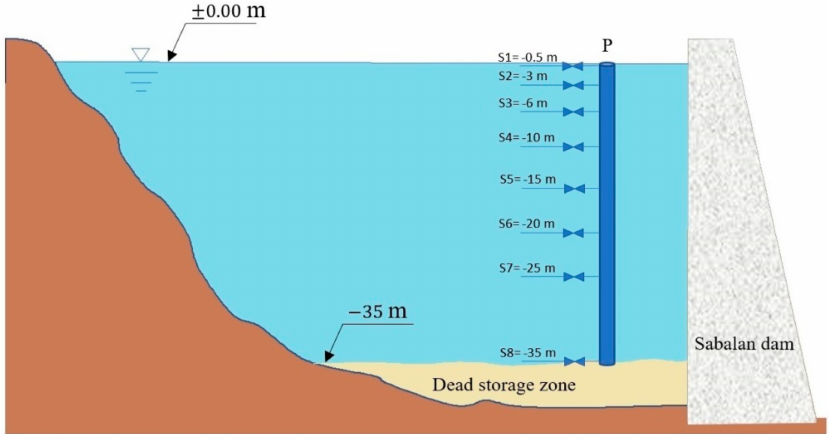
Figure 2. Schematic view of sampling points in different depths of the Sabalan dam